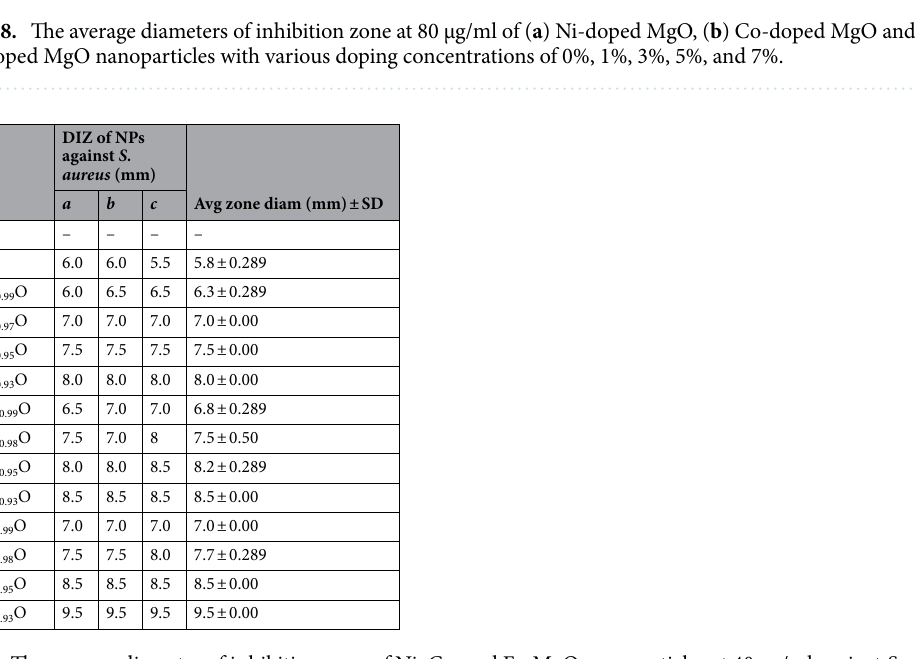
Table 6. The average diameter of inhibition zone of Ni, Co, and Fe-MgO nanoparticles at 40 μg/ml against S. aureus .